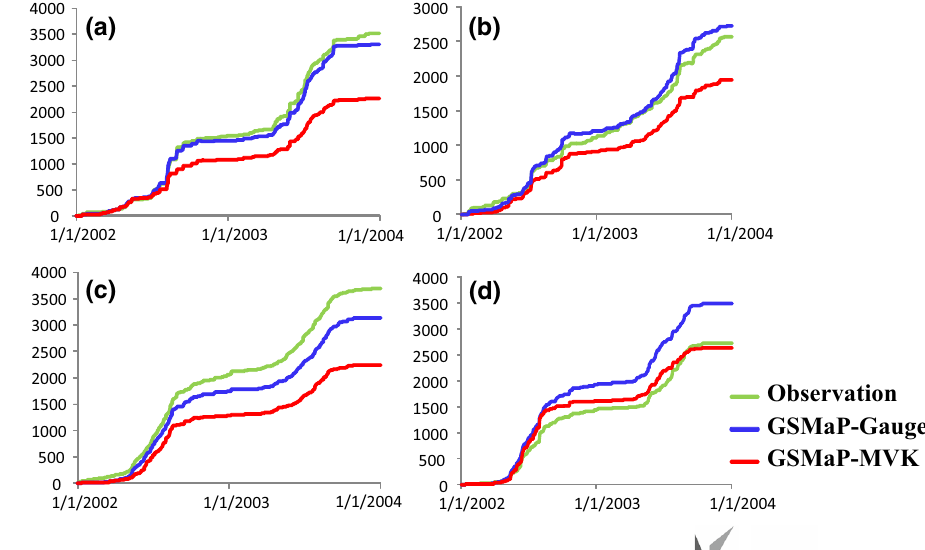
Fig. 3 Accumulated precipita- tion of GSMaP-MVK (red line) and GSMaP-Gauge (blue line) vs ground measurements (green line) in a Hyeonsan basin, b Fuji basin, c Da basin, and d Upper-Cau